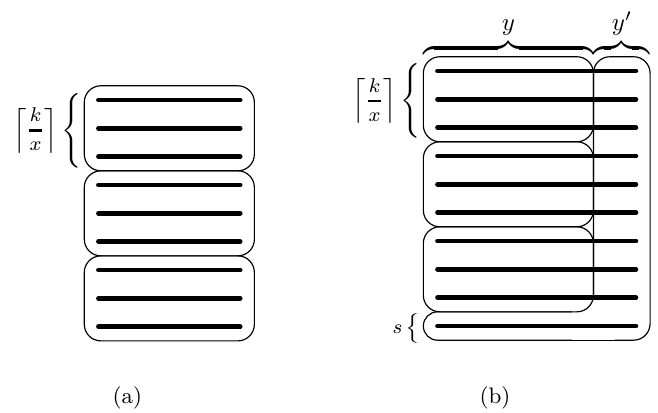
Figure 3: Graphical representation of the colouring approach in Algorithm α ( x, k ) for (a) Case 1 and (b) Case 2, where a balancing operation is performed on the last colour class. As before, the line segments represent normalised partite sets and colour classes are represented by means of rectangular or inverted, L–shaped